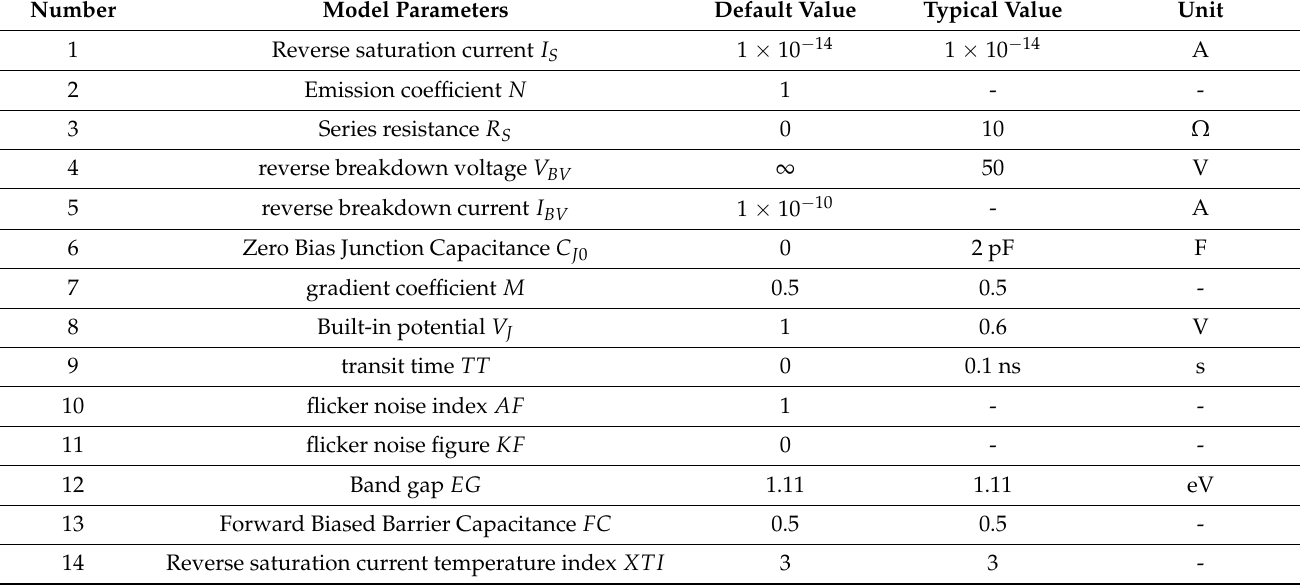
Table 1. The parameters of diode EMC model in “.MODEL”